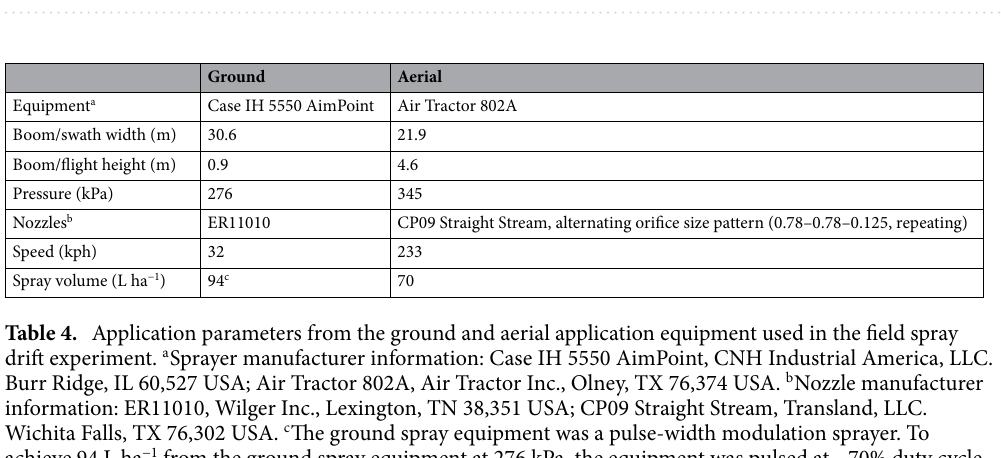
Figure 6. AgDRIFT and AgDISP modeling results for ground and aerial applications under field trial conditions using 20 consecutive passes.